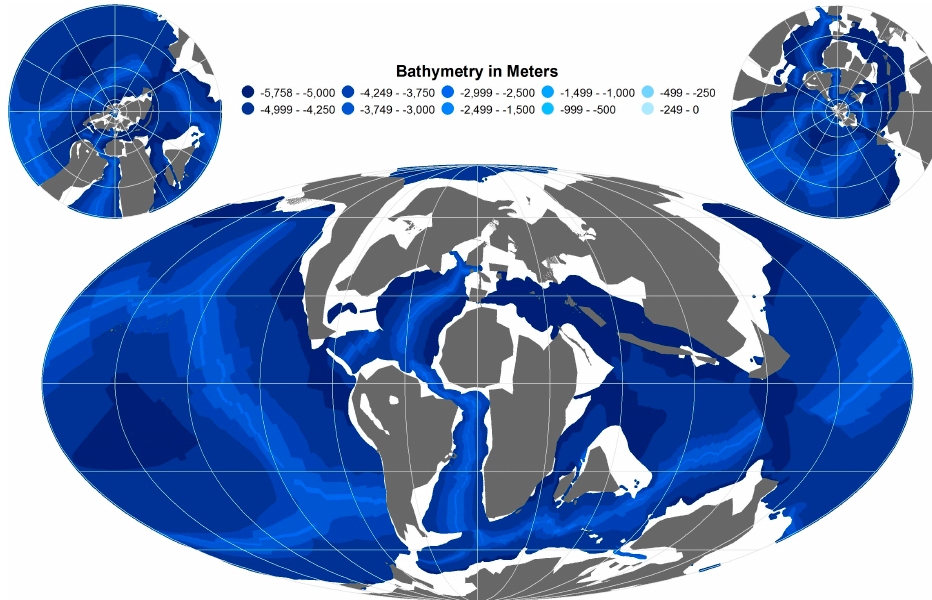
Figure 4. Depth-to-basement calculated from the age of oceanic crust at 94 Ma.